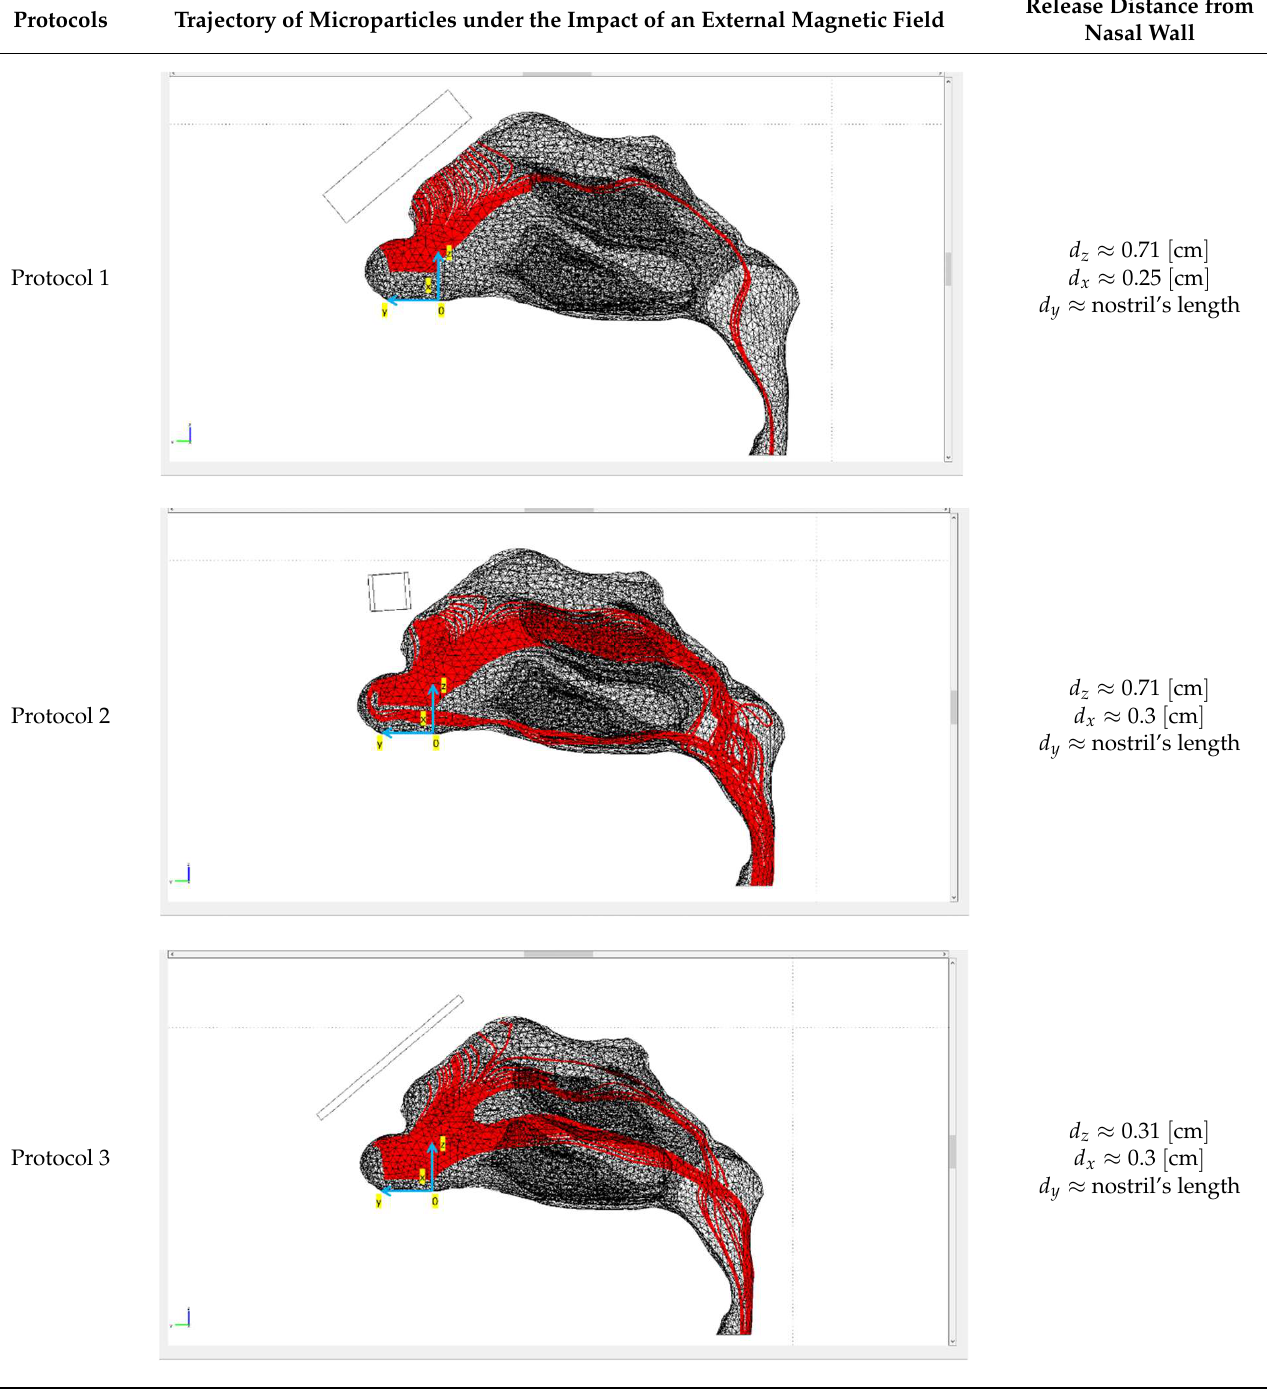
Table 1. The trajectories of the magnetite microparticles (in red) for each protocol under the influence of an external static magnetic field (1.2 T ) are illustrated. The point of release distance from the nasal wall for each protocol is also included.